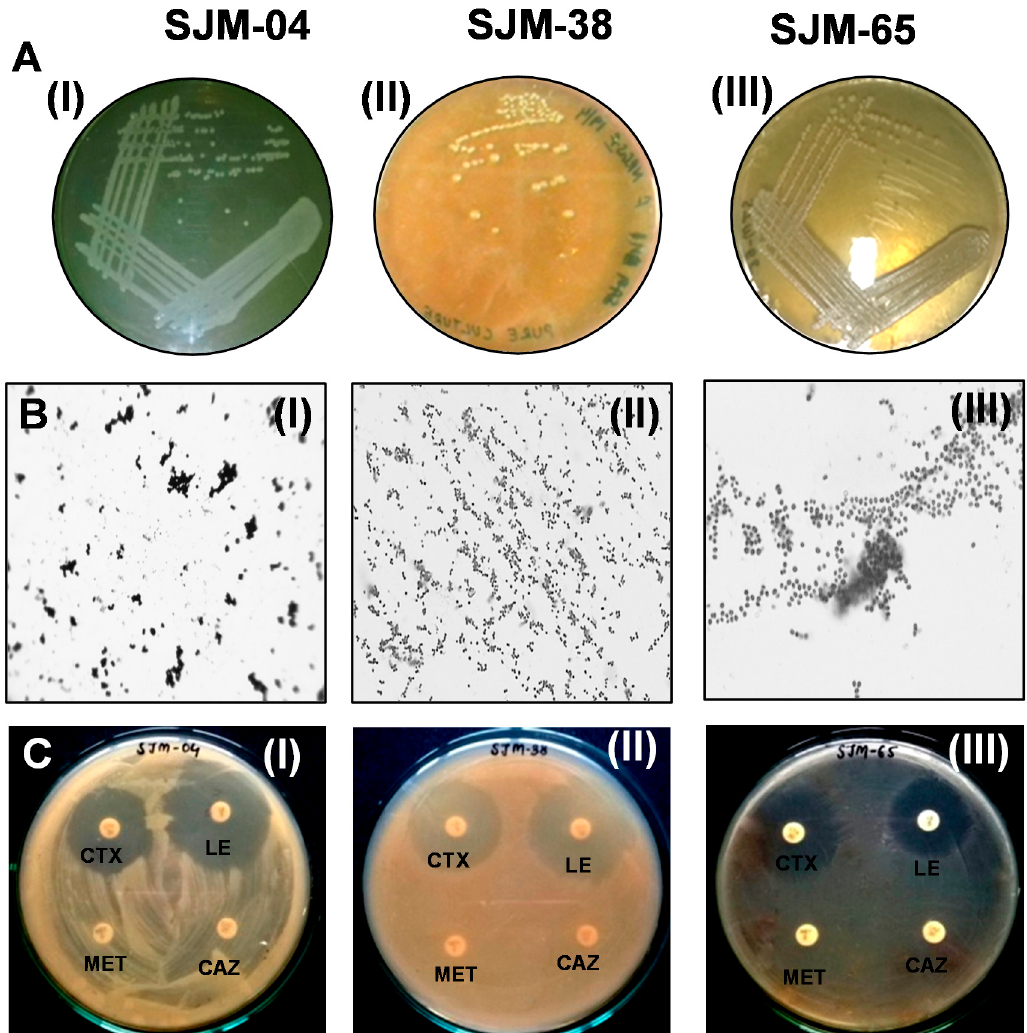
Figure 1. ( A , B ) show morphological characteristics of ( I ) SJM-04 ( Georgenia sp.), ( II ) SJM-38 ( S. saprophyticus ), and ( III ) SJM-65 ( R. mucilaginosa ) grown onto their respective culture media. ( C ) shows representative images of the antibiotic sensitivity or resistance of ( I ) SJM-04 ( Georgenia sp.), ( II ) SJM-65 ( S. saprophyticus ) and ( III ) SJM-38 ( R. mucilaginosa ) against multiple drugs.